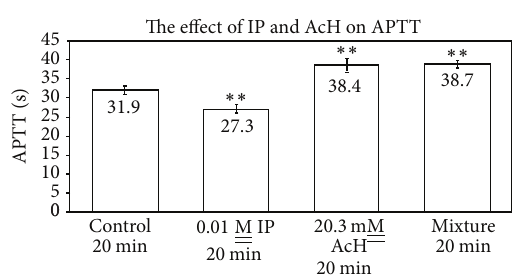
Figure 3: Effect of various D-amphetamine concentrations on APTT ( 𝑛 = 5 ; 𝑃 ≤ 0.02 for 0.01M D-Amp) ( 𝑛 = 10 ; 𝑃 ≤ 0.01 for the 20 min D-Amp-AcH mixture). ∗∗ indicate that 𝑃 ≤ 0.05 relative to the control APTTs.